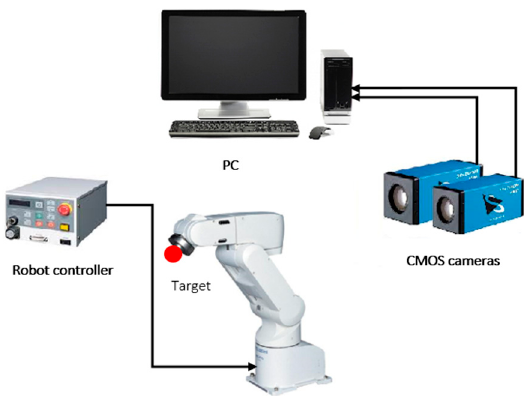
Figure 12. Vision tracking system architecture.